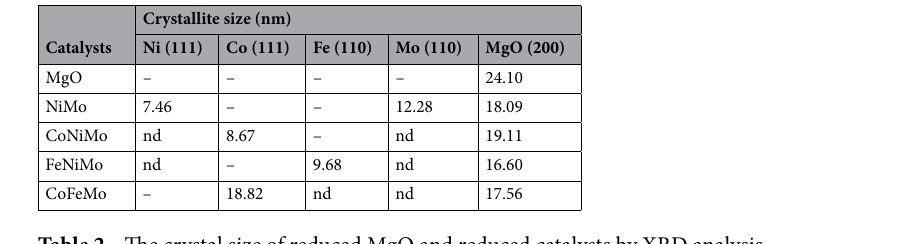
Table 2. The crystal size of reduced MgO and reduced catalysts by XRD